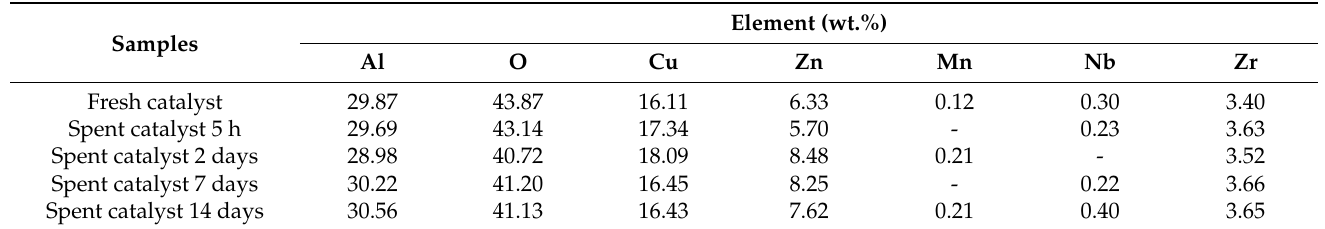
Table 4. Elemental compositions of samples using EDX analyses on Al